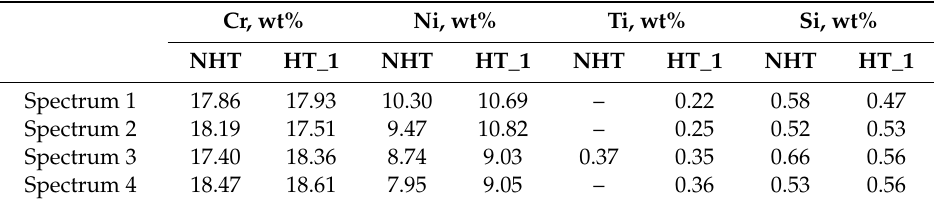
Table 3. Content of chemical elements in di ff erent spectra of NHT and HT_1 samples.